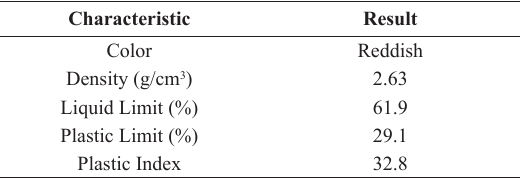
Table 2. Characteristics of the red clay used (wt%).